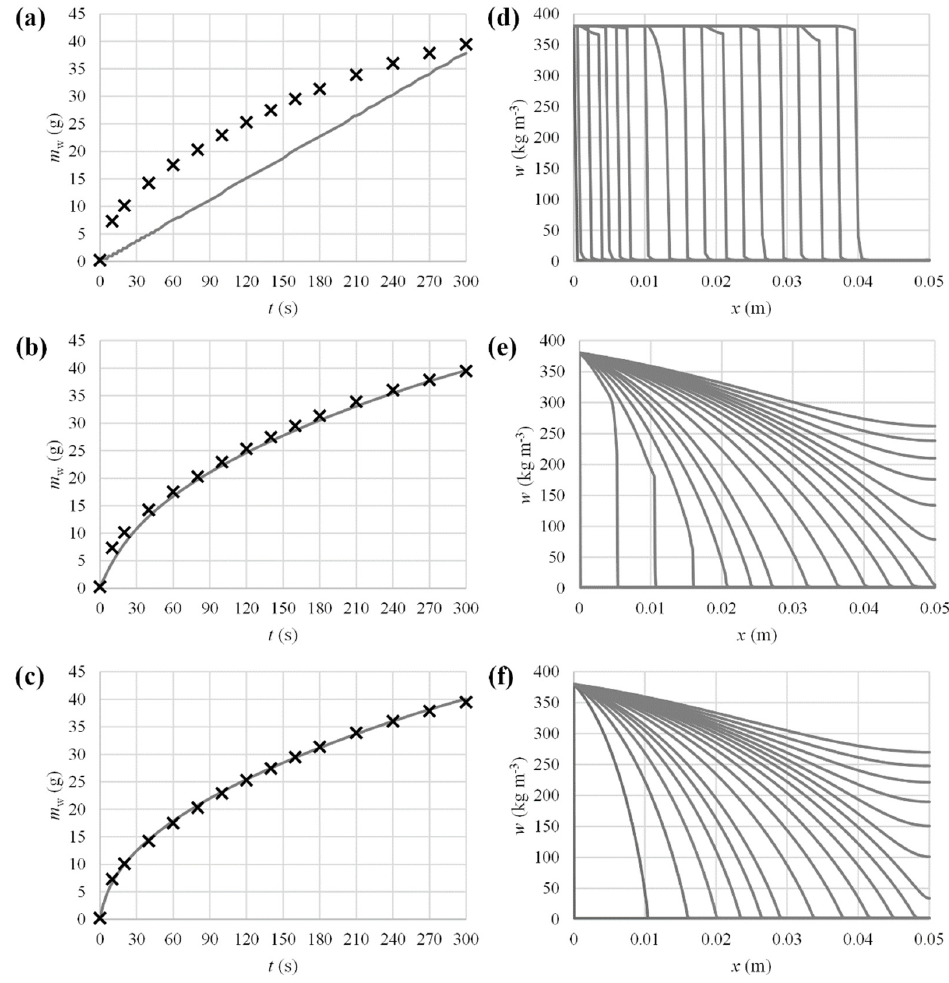
Figure 1. (Left panel) Evolution of the cumulative water mass in for: ( a ) 100 nodes, ( b ) 400 nodes and ( c ) 800 nodes. Markers, experimental data; solid line, FLoW1D results. (Right panel) Moisture content isochrones ( w ) obtained with FLoW1D for: ( d ) 100 nodes, ( e ) 400 nodes and ( f ) 800 nodes. Times: 10 s for the first minute and 20 s for the next four minutes. Using the parameters of OPS limestone, variant 1 is given in Table 1 from the critical comments by prof. Janssen.